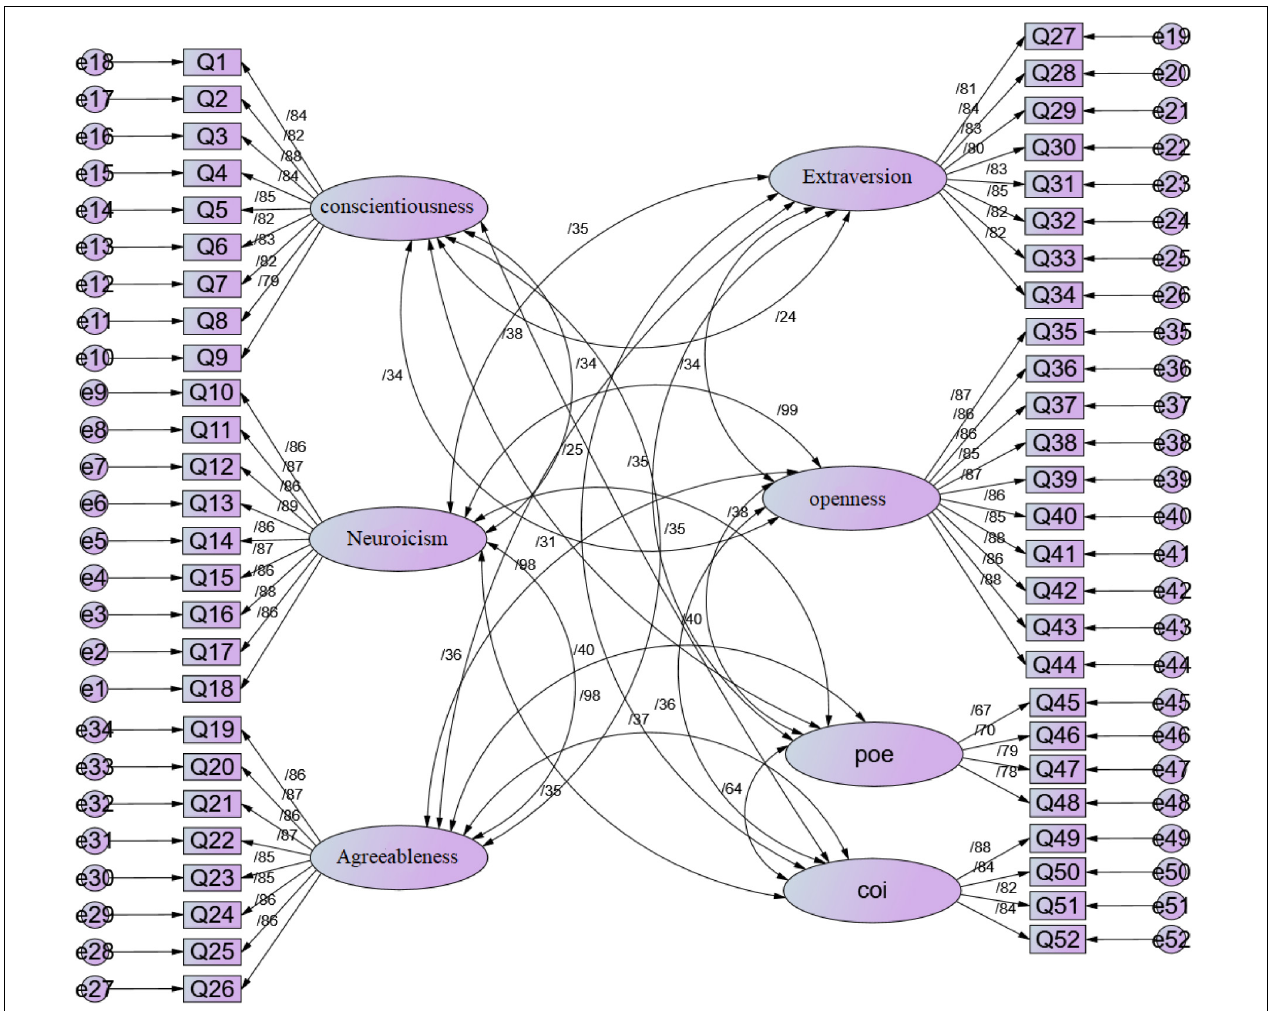
FIGURE 2 | Standardized factor load coefficients of confirmatory factor